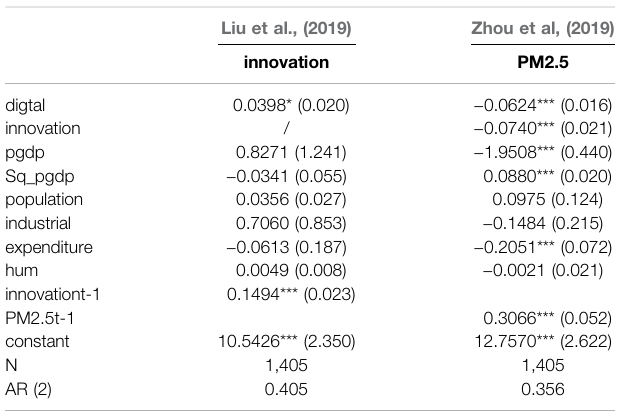
TABLE 3 | Results of the mediating